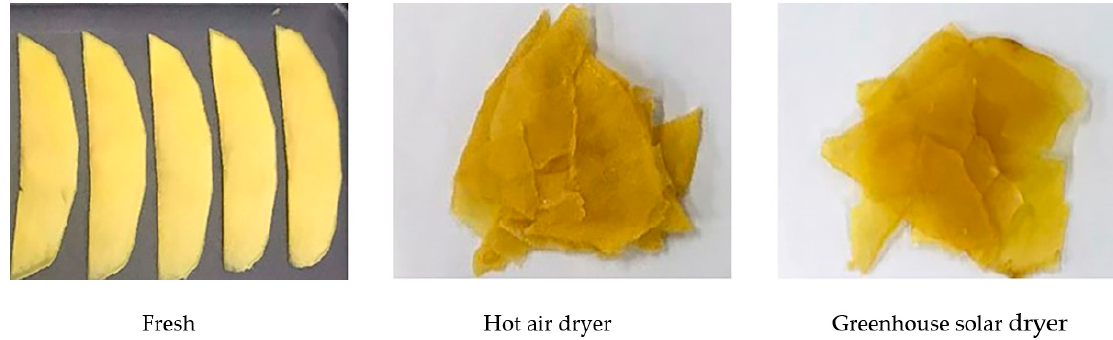
Figure 7. Appearance of fresh and dried mango slices from different drying systems. Table 1. Color characteristics of fresh and dried mango slices from different drying conditions.